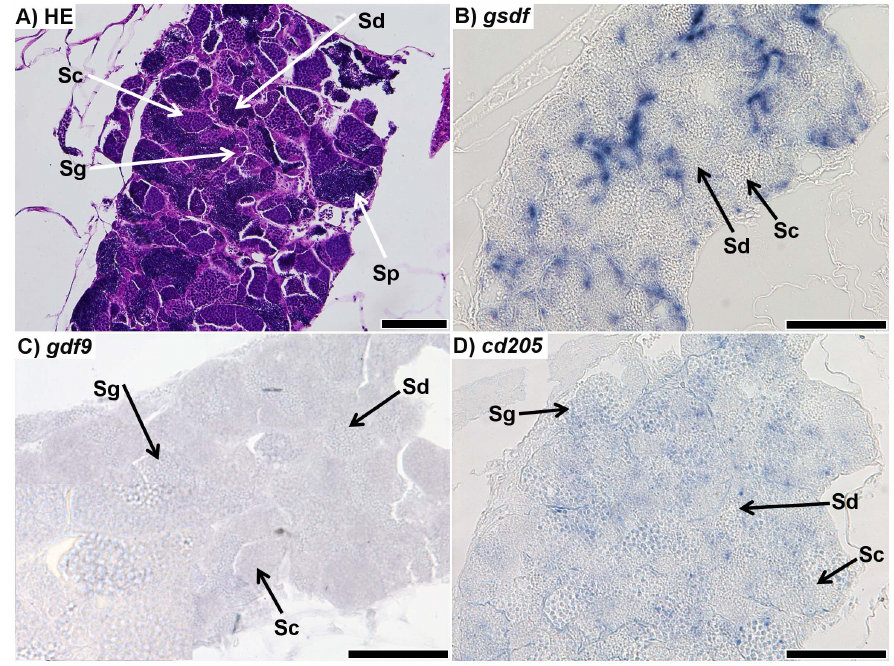
Figure 2. Sections of testis from 7 month-old zebrafish. A) Respresentative haematoxylin-eosin (HE) staining of the mature zebrafish testis; spermatogonia (Sg), spermatocytes (Sc), spermatids (Sd), and spermatozoa (Sp) could all be positively identified. B) in situ hybridization (ISH) of gsdf transcripts in the testis; staining shows strong signal throughout the testis, although it is unclear from which cell type it originates; no staining is visible in spermatocytes or spermatids. Spermatogonia and spermatozoa could not be identified. C) ISH of gdf9 transcripts in testis; faint signal was found throughout the testis. It is unclear which cell types the signal is localized to. D) ISH of cd205 transcripts in the testis; the signal is strongest in spermatogonia, while it is not visible in spermatocytes or spermatids. Spermatozoa could not be identified. All scalebars represent 100 m